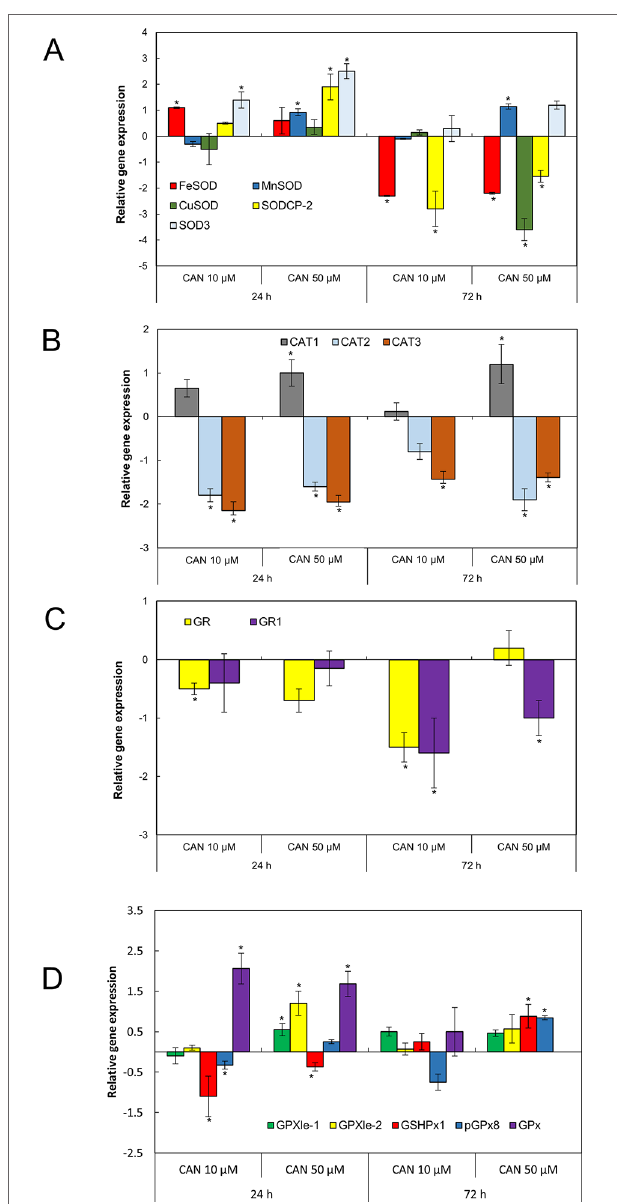
FIGURE 4 | The expression level of genes encoding different isoforms of SOD: MNSOD , CUSOD2 , FESOD , SODCP.2 , SOD3 (A) ; CAT: CAT1 , CAT2 , CAT3 (B) ; GR: GR , GR1 (C) ; and GPx: GPXle-1 , GPXle-2 , GSHPx1 , pGPx8 , GPx (D) analyzed by qRT-PCR as described in the section of Material and Methods . Roots of tomato seedlings were collected after 24 or 72 h of CAN (10, 50 µM) treatment; as a control, roots of plants cultured in water were used. Asterisks (*) indicate significance between treatments and the control at the same time of culture period at P ≤ 0.05, based on Student’s